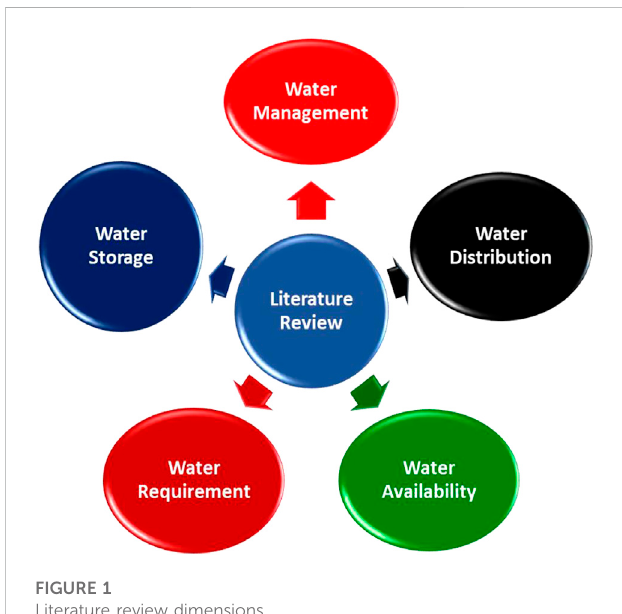
FIGURE 1 Literature review